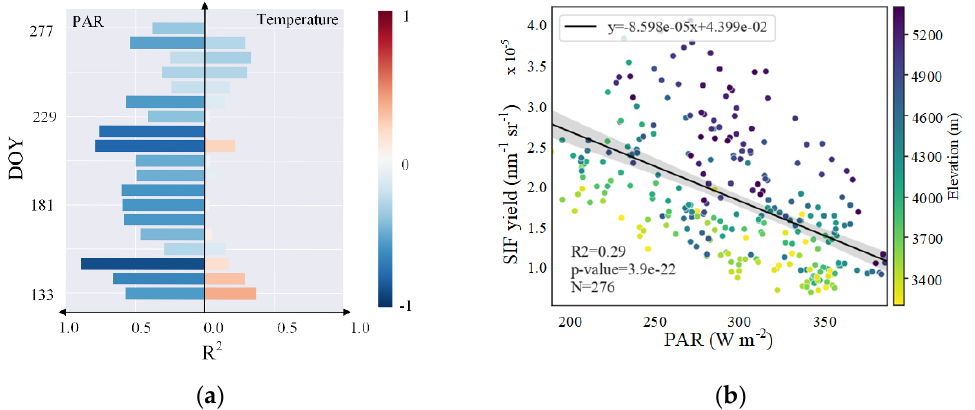
Figure 5. ( a ) Variations in R 2 between SIF yield and environmental variables (PAR and temperature). Observations from DOY 133–277 are used. Color of bars indicates direction of correlation (red indicates positive and blue indicates negative); deeper color indicates higher R 2 . ( b ) Relationship between SIF yield and PAR at different elevations on DOY 205 (July, the peak of summer growth period).